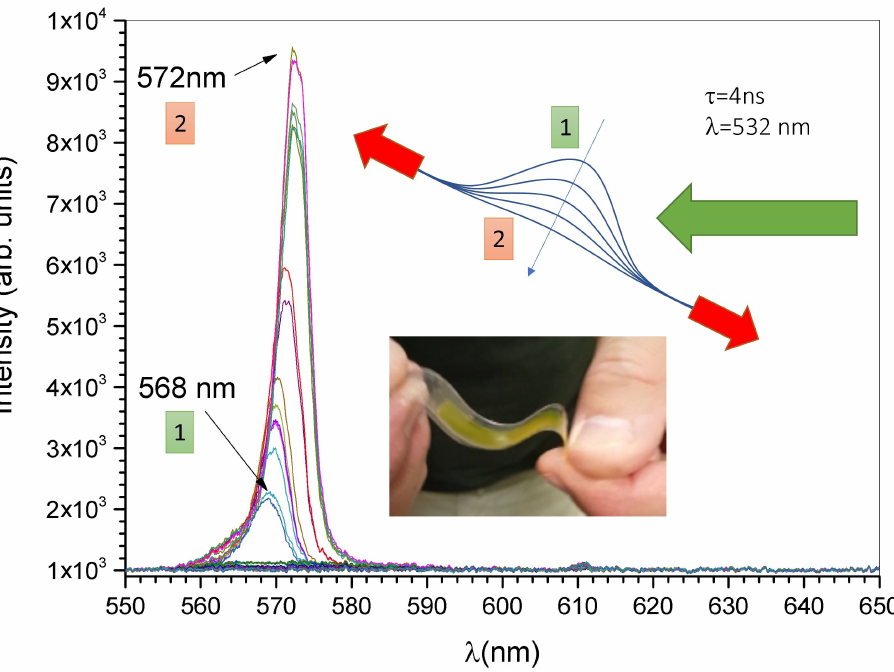
Figure 7. Demonstration of the tuning possibilities of the free-standing film. On the right side a sketch of the experimental setup. By stretching the film along the directions indicated by the red arrows, bending occurs and the emission can be tuned from 568 to 572 nm. The real device is shown in the